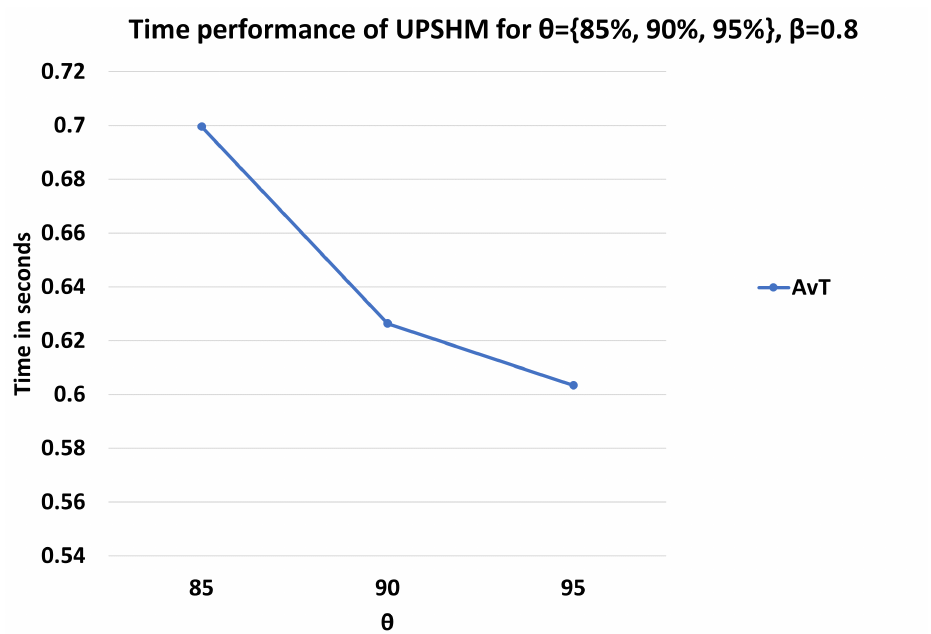
Figure 10. Average Time for decision offloading of UPSHM for different values of θ